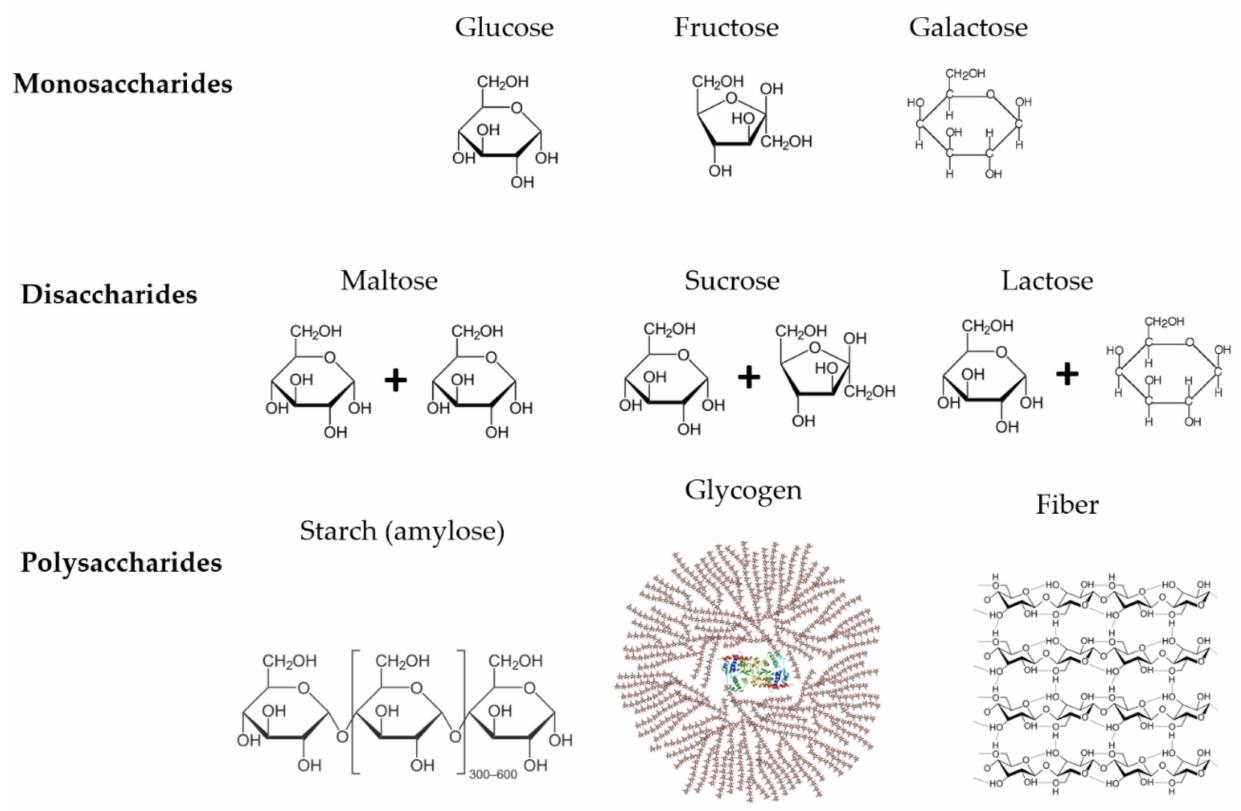
Figure 1. Chemical composition of